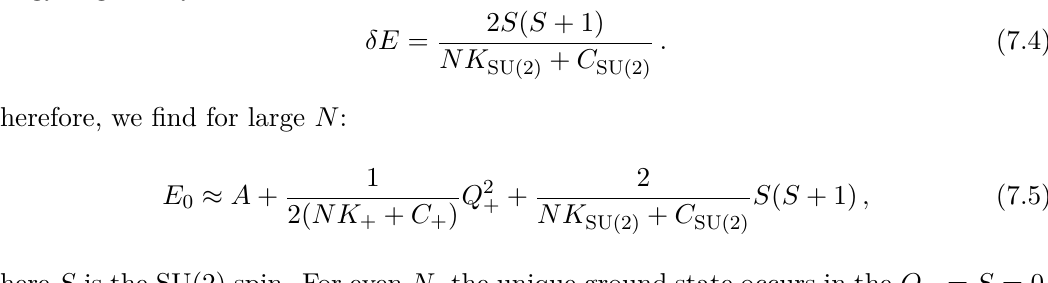
against N to estimate the SU(2)